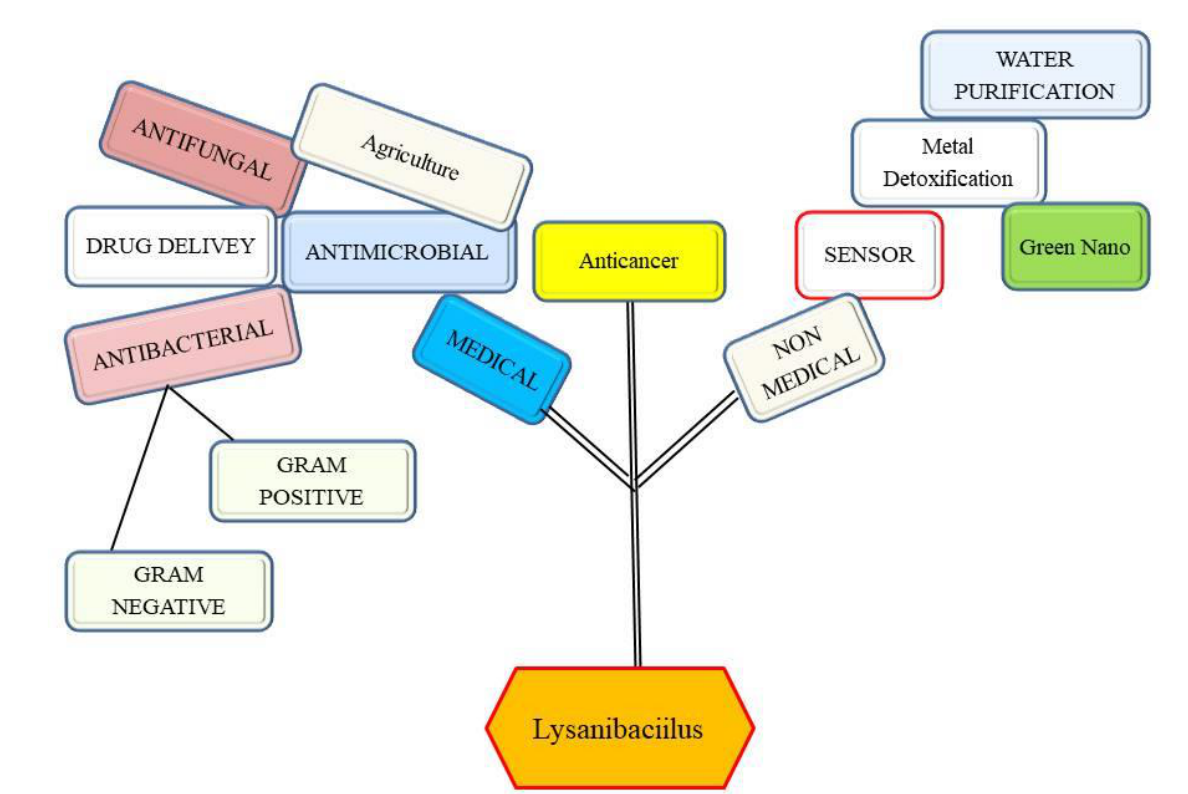
Figure 1. Potential applications of Lysinibacillus species in human welfare.